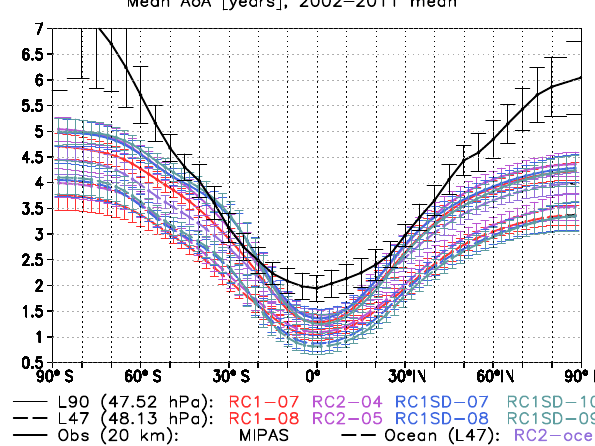
Figure 23. Annual mean tropical upward mass flux (10 8 kgs − 1 ) at 70 / 74hPa (top), 9 / 10hPa (middle), and 1hPa (bottom). The simu- lation results (colours) are compared to ERA-Interim data (black).